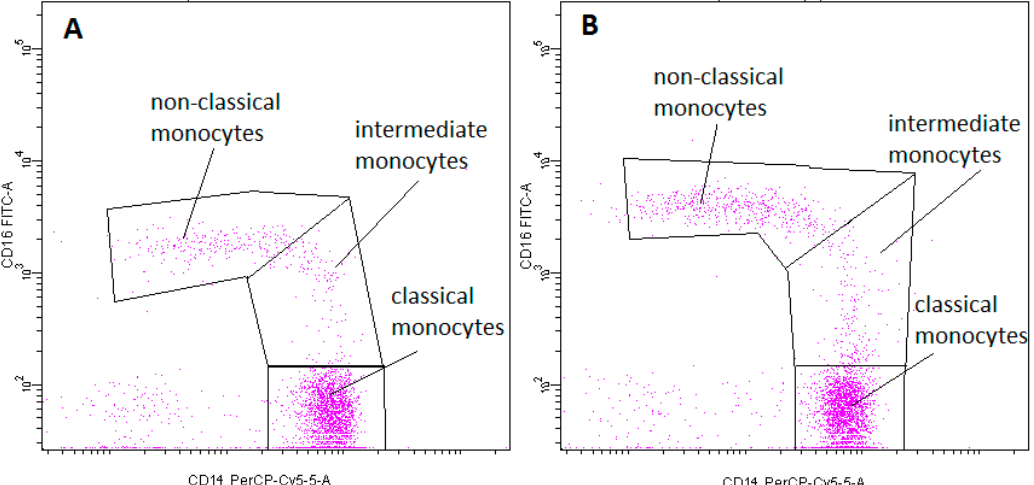
Figure 13. Exemplary plots of flow cytometry analysis showing the staining with antibodies specific for CD14 and CD16 in monocyte fraction: ( A ) peripheral blood ( B ) FNAB. Gating of individual monocyte subpopulations is presented: classic monocytes (CD14 high CD16 − ), intermediate monocytes (CD14 high CD16 + ), non-classical monocytes (CD14 low CD16 + ).